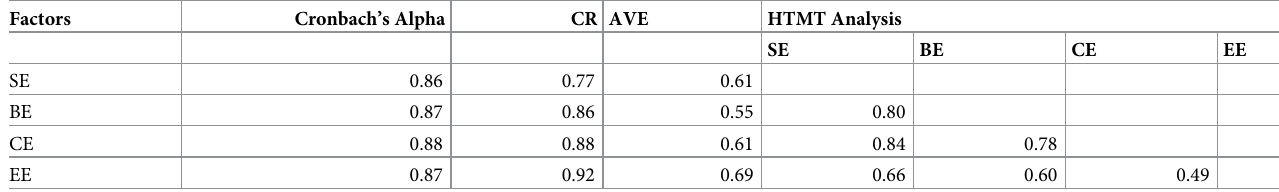
Table 1. Detail of reliability and